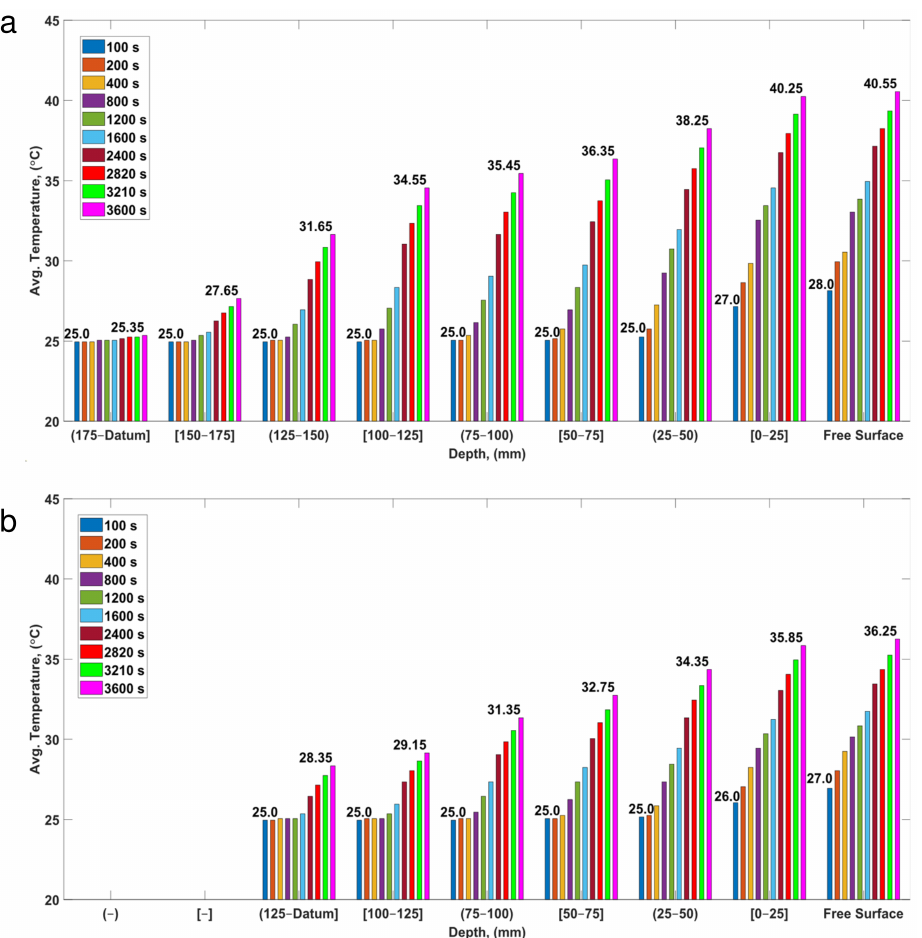
Figure 19. Temporal variation in bulk average temperature with respect to the elevation ranges in the pool for aspect ratios of ( a ) 0.5 (Case J) and ( b ) 2.0 (Case K); free surface temperature is area-averaged